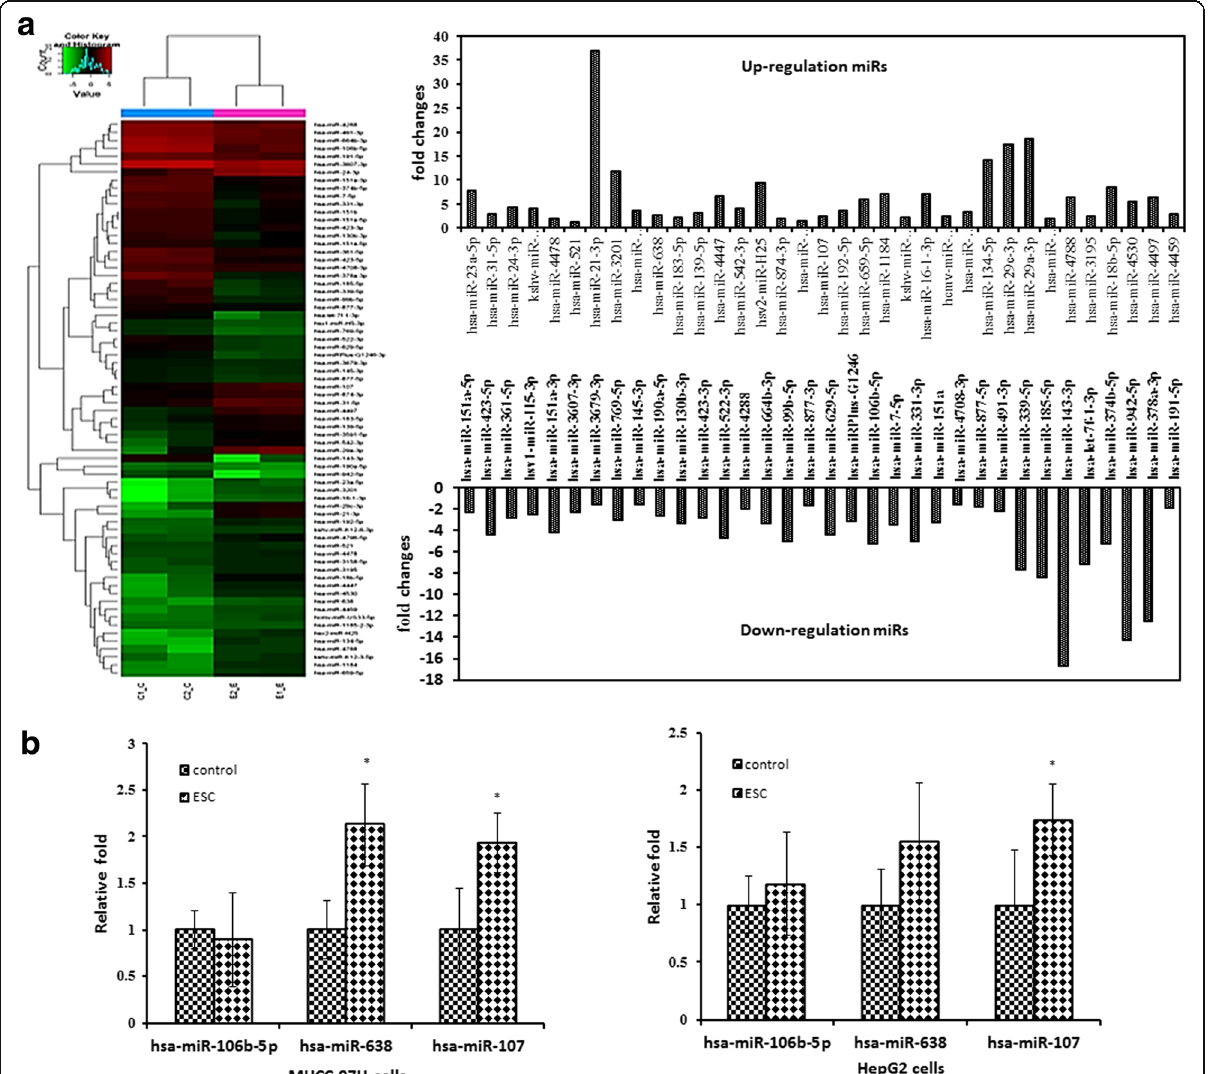
Fig. 4 miRNA expression profiles of HCC cells treated with ESC. a Profile of miRNAs of MHCC97H cells treated with ESC. b Part differential miRNA expressions were verified with realtime PCR in MHCC97H and HepG2 cells. *p < 0.05, **p < 0.01 vs